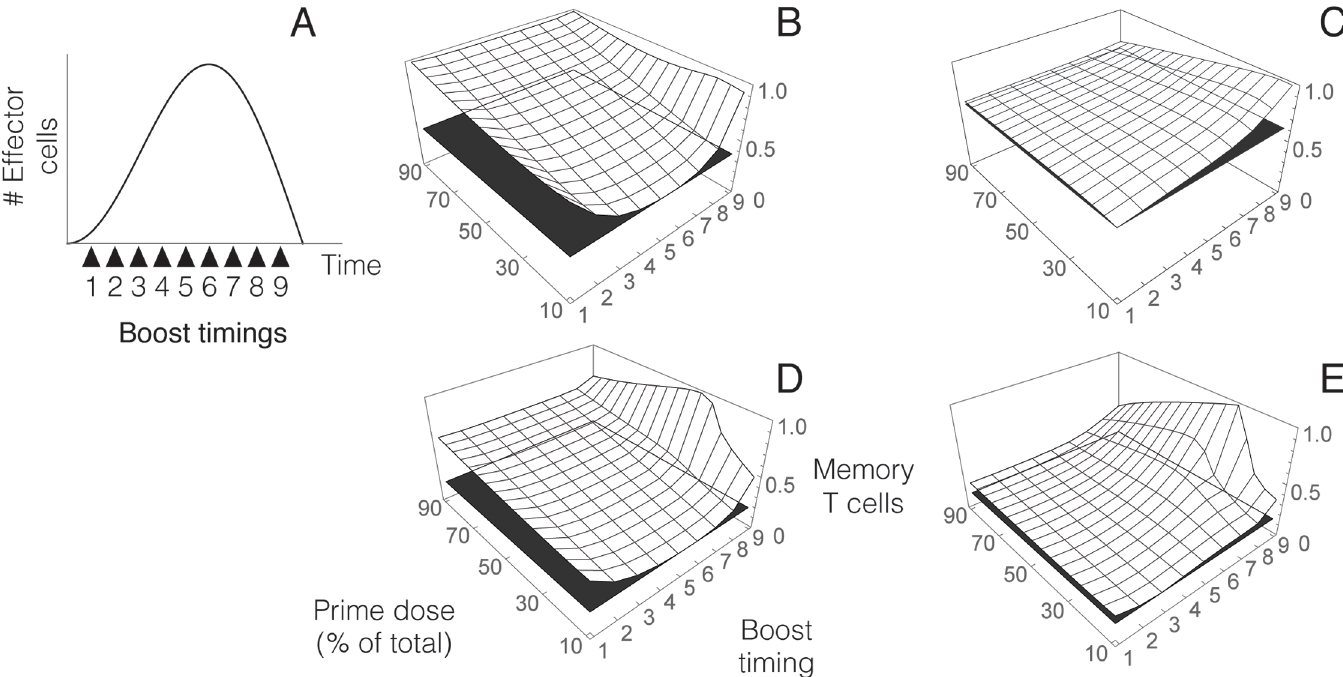
Fig 3. Numerical simulations of the model of homologous PB regimes with different parameters values. A). Behavior of effector T cells after prime according to Eq (1). PB protocols are defined by choosing nine boost timings equally distributed between the initiation of the T cell response and the end of clonal contraction. B) Memory T cells formed for PB protocols that differ in prime dose and boost time, using a high total antigen dose. C) As B with lower antigen load. Results are normalized relative to the maximum in each figure. Black planes show the minimum value of memory formation for comparison. D,E) Same as B and C for a different choice of parameter values. The values of the parameters used in these simulations are the following (in suitable units): (B) A 0 = 20000, λ A = 450, c = 40, k = 250, λ H = 10, φ = 10 7 , μ = 1, α = 15, β = 0.04 and E a (0) = M a (0) = 10. (C) Same as in B, with A 0 = 200. (D) A 0 = 10000, λ P = 250, c = 50, k = 120, λ H = 10, φ = 10 7 , μ = 1, A 0 = 10 7 , μ = 1, α = 2, β = 0.2 and E a (0) = M a (0) = 10. (E) Same as in C, with A 0 =